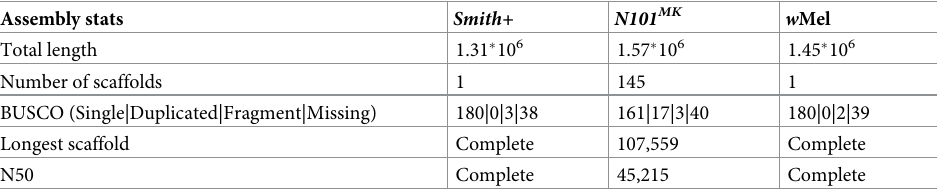
Table 4. Assembly statistics for Smith+ and N101 MK , with the complete w Mel genome for